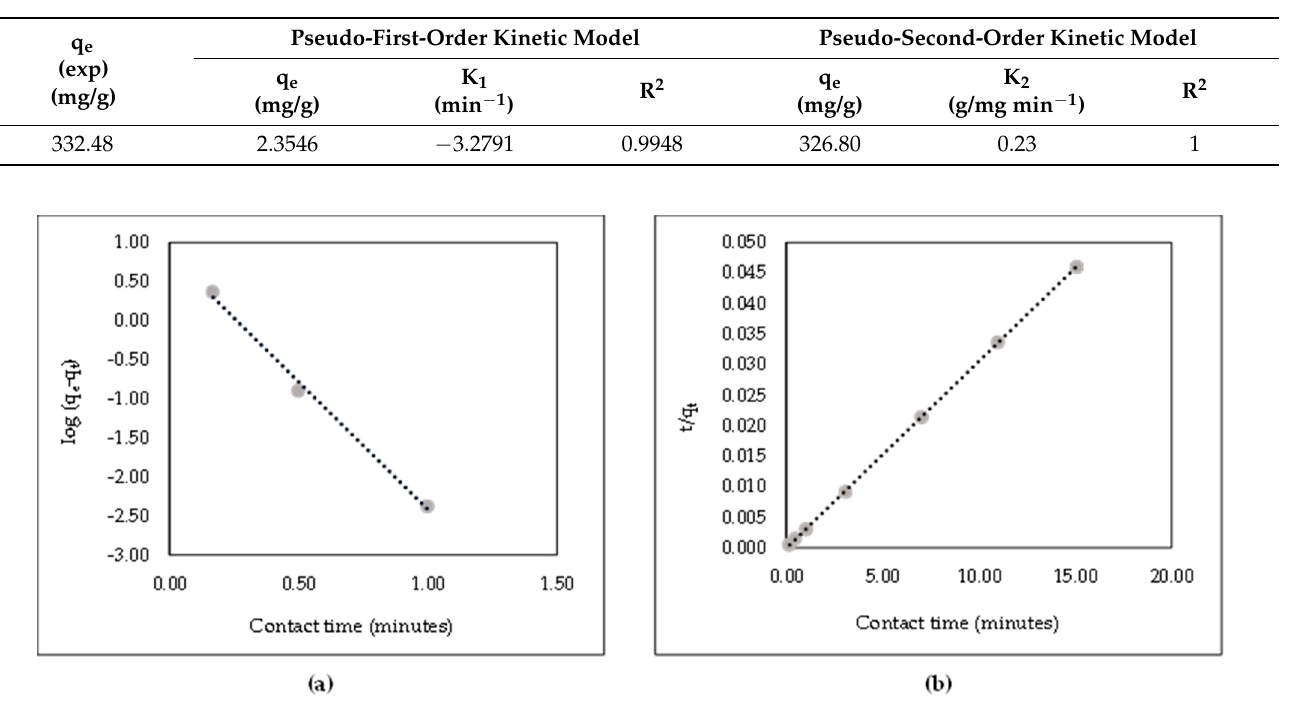
Figure 9. Linear kinetics plot of AR88 removal onto ZL-CH hydrogel (initial AR88 concentration = 100 mg/L, pH 2.0). ( a ) Pseudo-first-order kinetic model; ( b ) pseudo-second-order kinetic model.